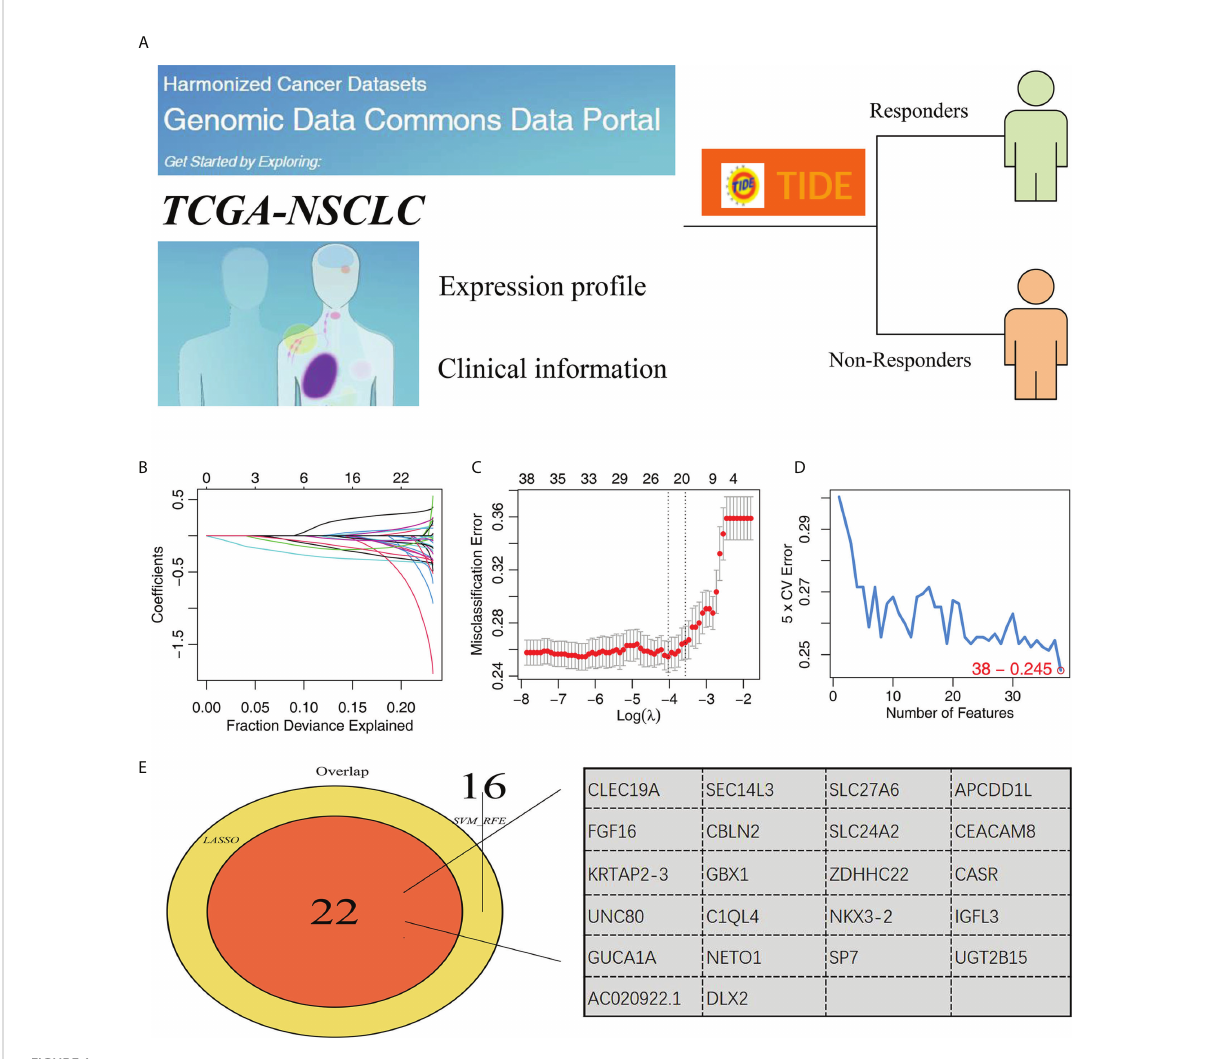
FIGURE 1 Identi fi cation of characteristic genes of NSCLC immunotherapy. (A) TIDE algorithm was performed to evaluate the immunotherapy of NSCLC patients, of which TIDE scores > 0 were non-responders and < 0 were responders; (B, C) LASSO logistic regression; (D) SVM-RFE algorithm; (E) Two algorithms identi fi ed 34 characteristic